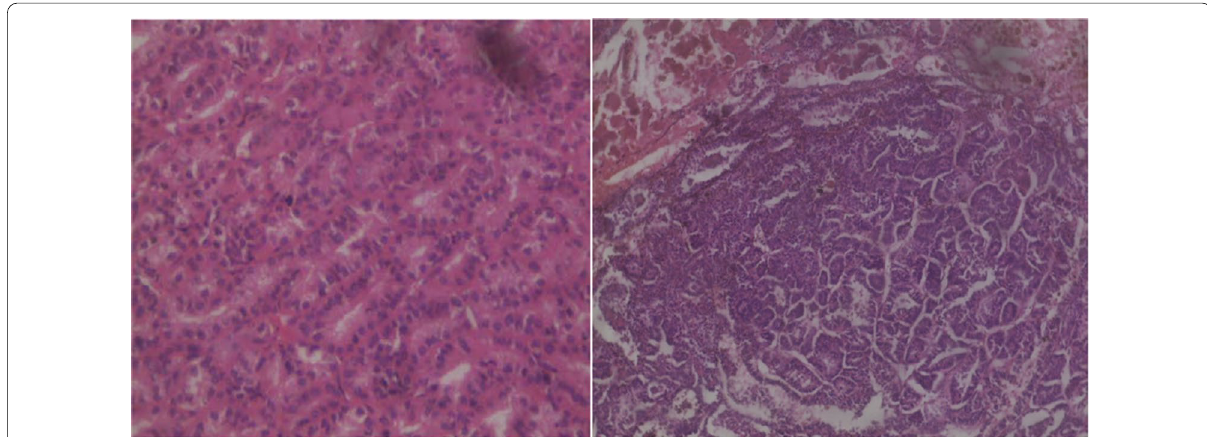
Fig. 3 H&E stain slides showing papillae lined with pseudo‑stratified layers of cells with abundant eosinophilic cytoplasm typical of papillary renal cell carcinoma (magnification 100 and 40, respectively) × ×